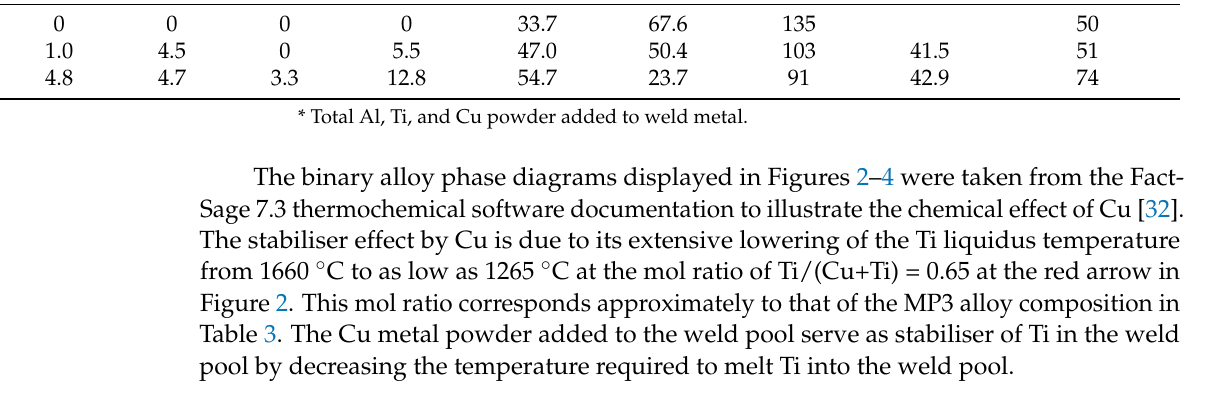
Table 3. The Cu metal powder added to the weld pool serve as stabiliser of Ti in the weld pool by decreasing the temperature required to melt Ti into the weld